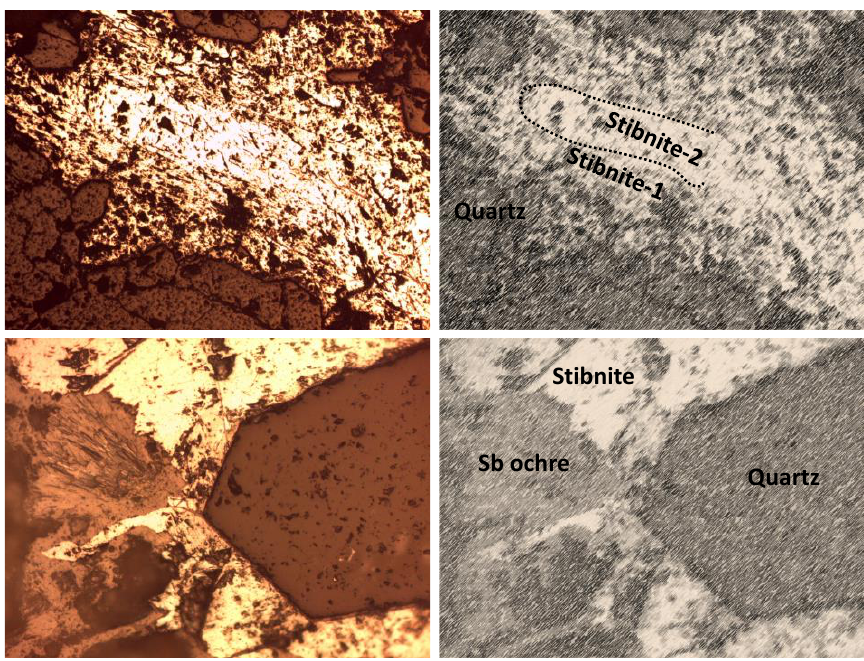
Figure 3. ( Above ): Typical texture of the primary mineralization — quartz and stibnite (two generations) filling open cavities within the host limestone (width of view: 2.6 mm). ( Below ): Detail of